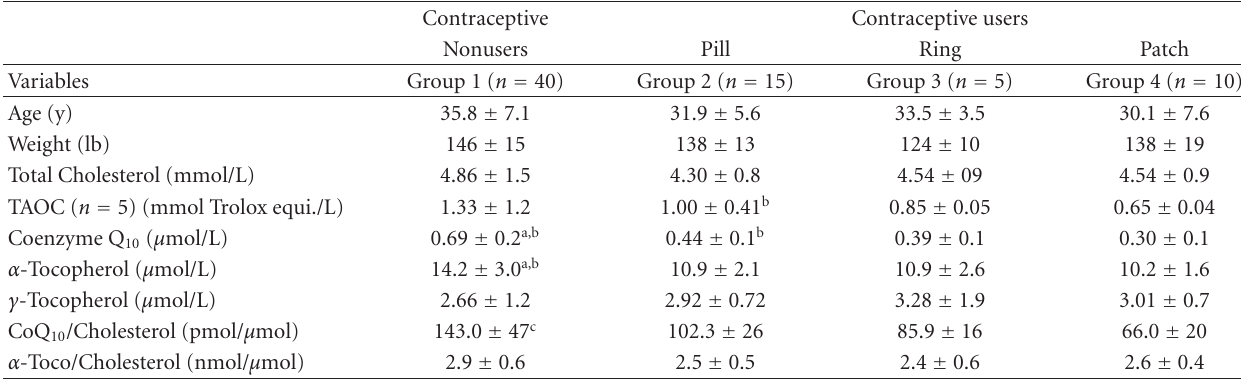
Table 1: Age, weight, and serum levels of total cholesterol, coenzyme Q 10 , α -tocopherol, and γ -tocopherol, the ratios of coenzyme Q 10 /cholesterol and α -tocopherol/cholesterol in women who used the contraceptive pill, vaginal ring, or transdermal patch and control